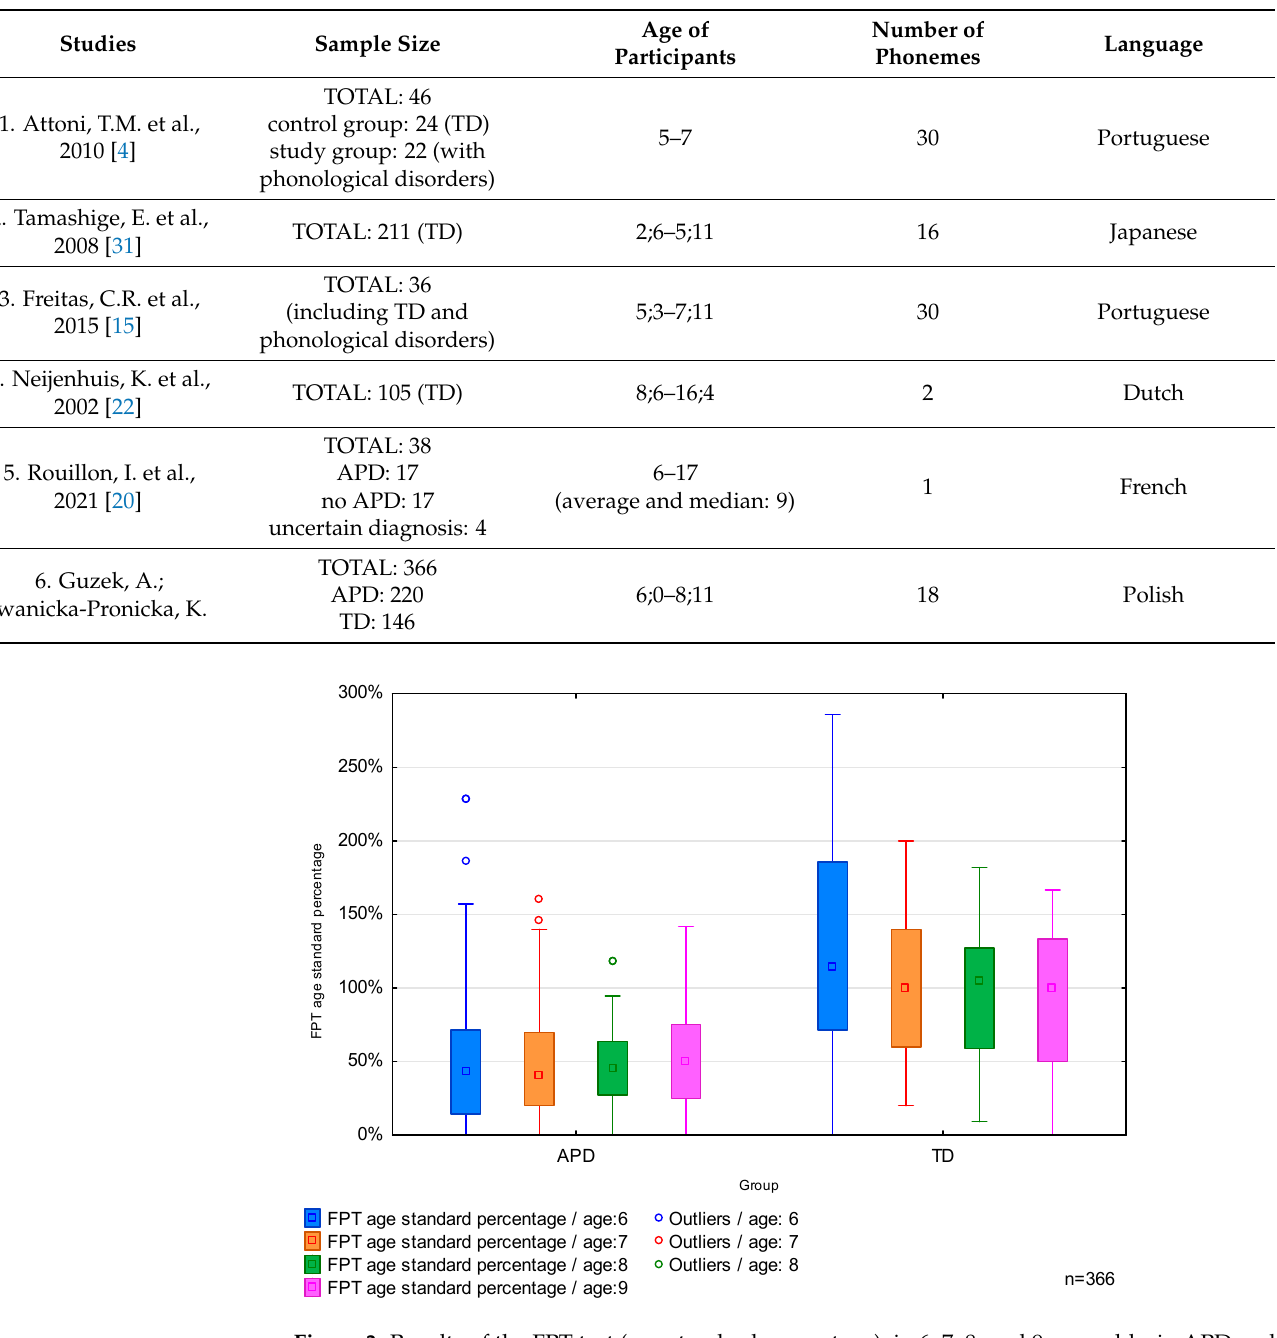
Table 8. Studies on phoneme discrimination development (TD participants and participants with phonological disorders or APD).